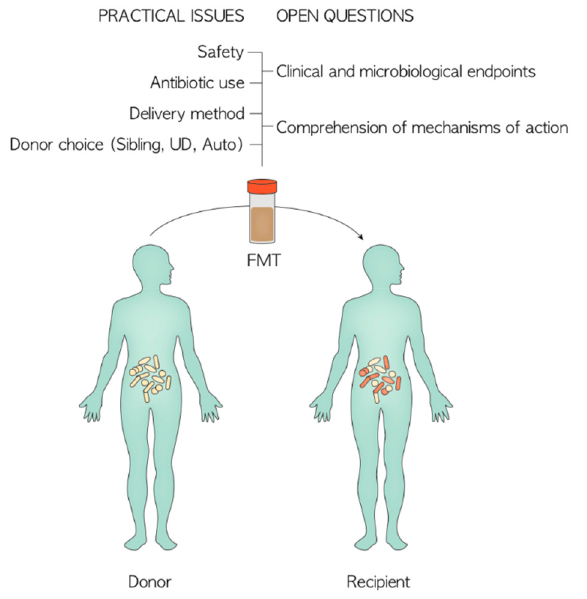
Figure 2. Practical issues and open questions to address in the design of future FMT intervention. UD: Unrelated Donor.